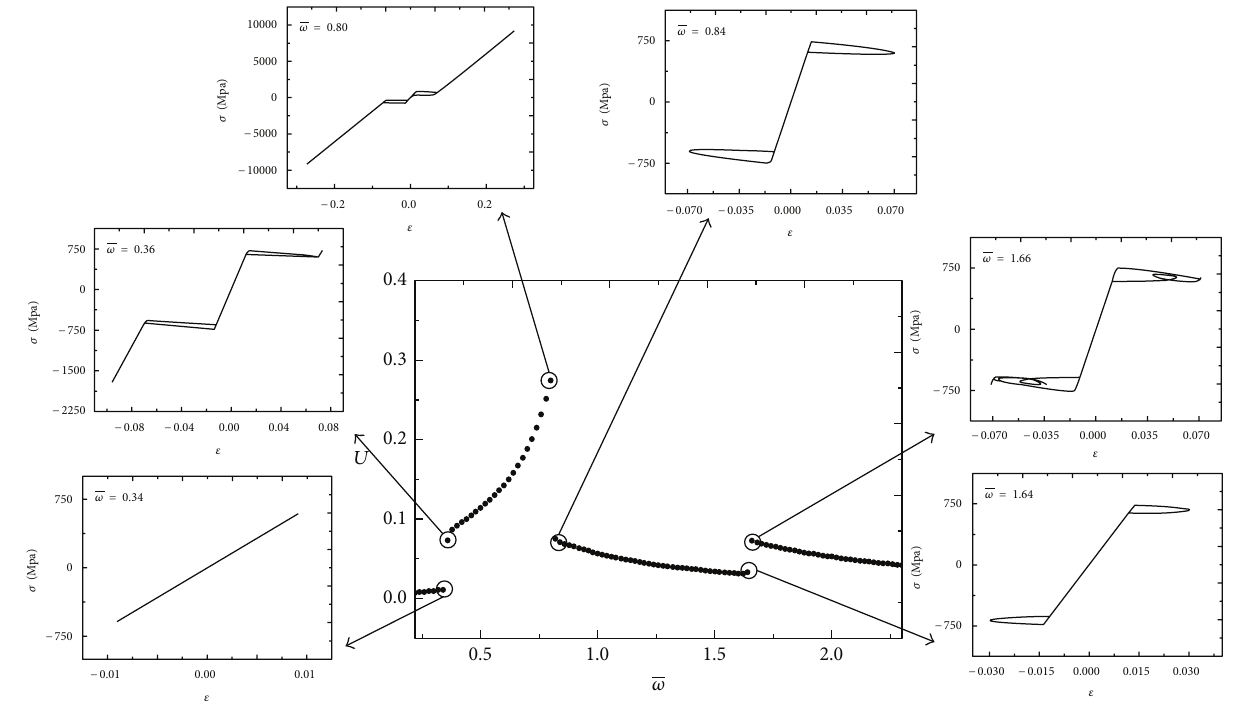
Figure 7: Down-sweep jumps with V = 0.075 m/s: comparison between frequency response and stress-strain